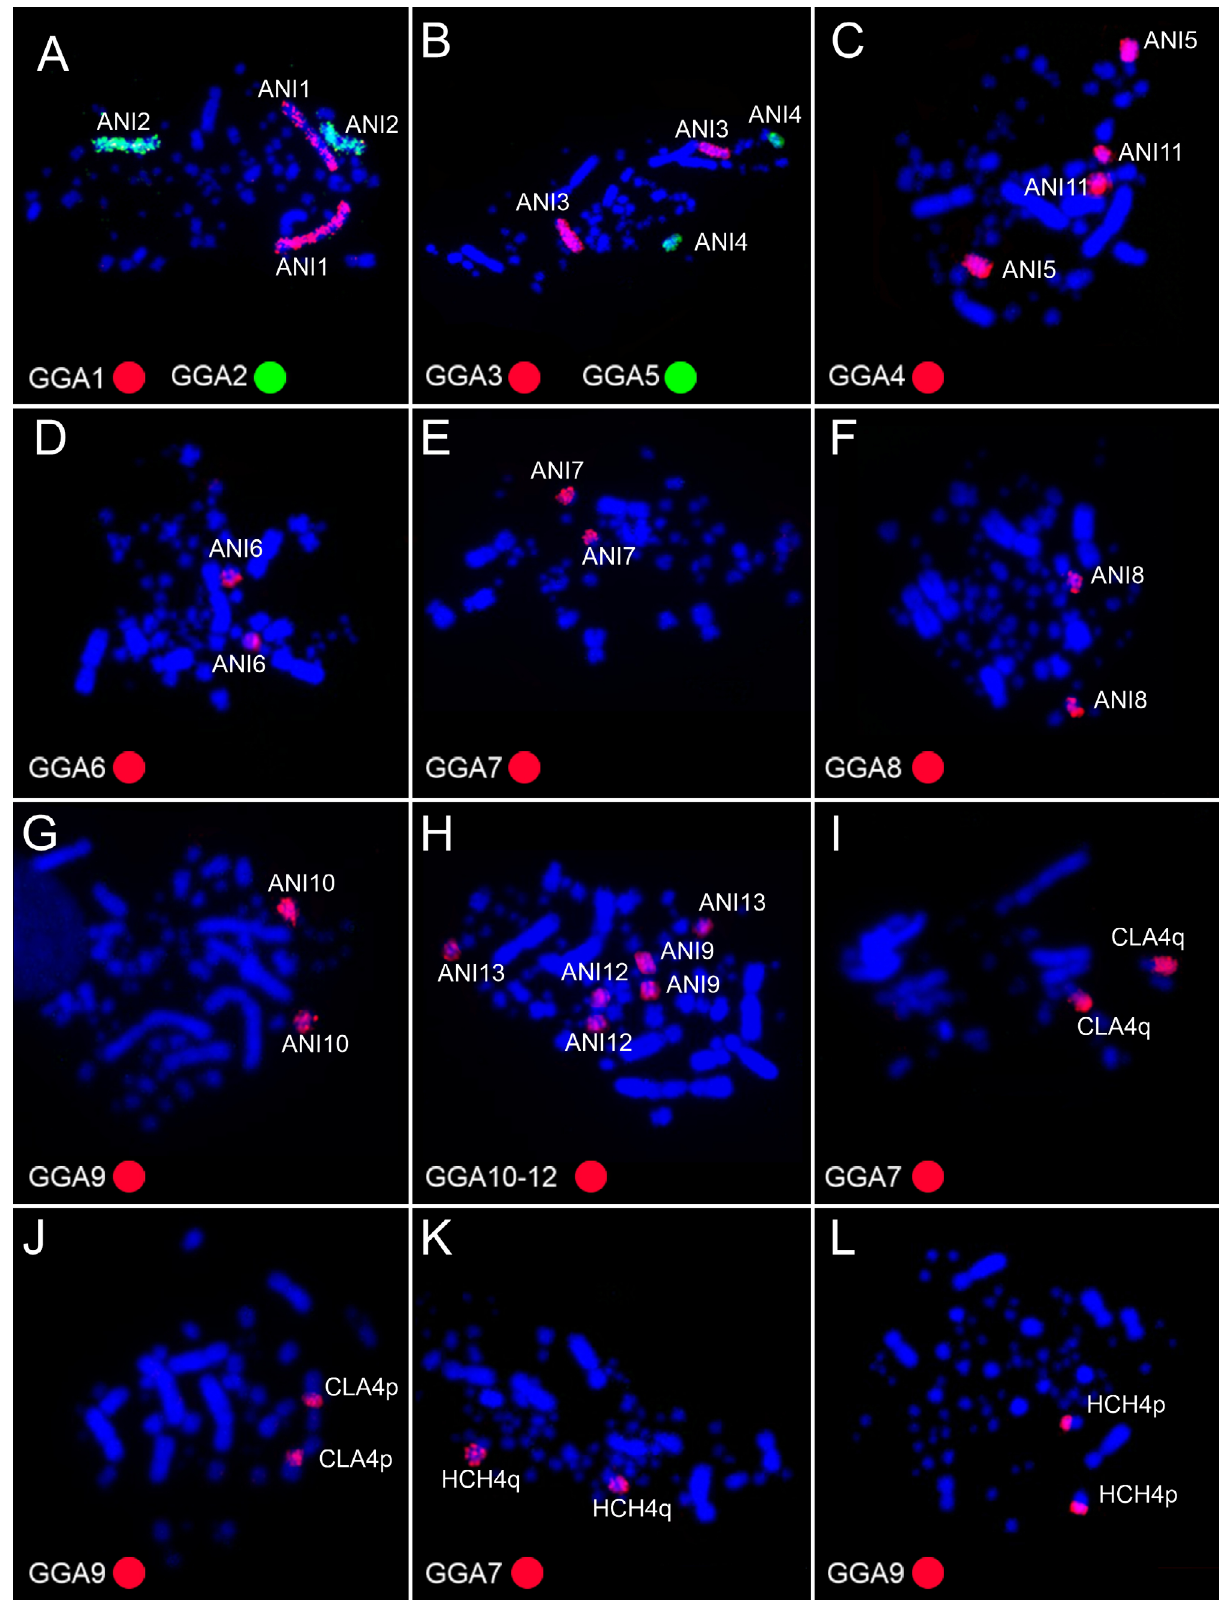
Figure 2 – Representative metaphases showing Fluorescence in situ Hybridization using Gallus gallus (GGA 1–GGA12) chromosomal probes in Anthracothorax nigricollis , ANI (metaphases A–H), and the GGA7 and GGA9 probes in Campylopterus largipennis , CLA (metaphases I and J) and Hylocharis chrysura , HCH (metaphases K and